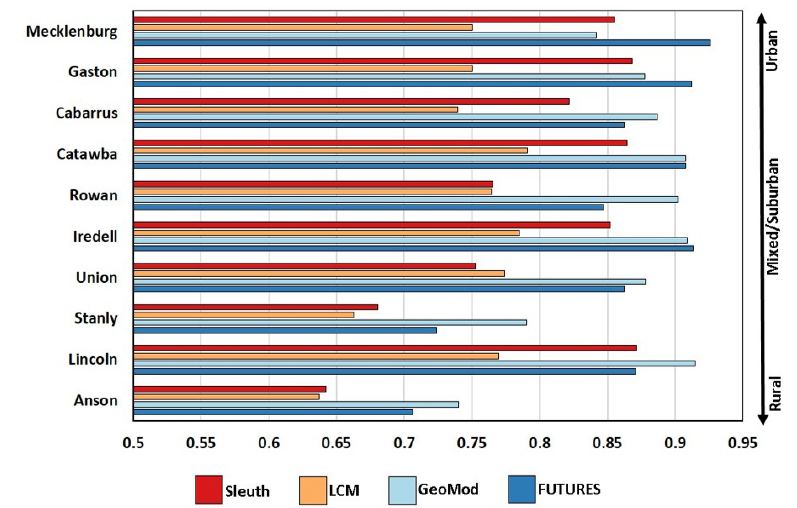
Figure 5. Landscape Similarity Index for each land change model stratified by county. Configuration disagreement is equal to one minus